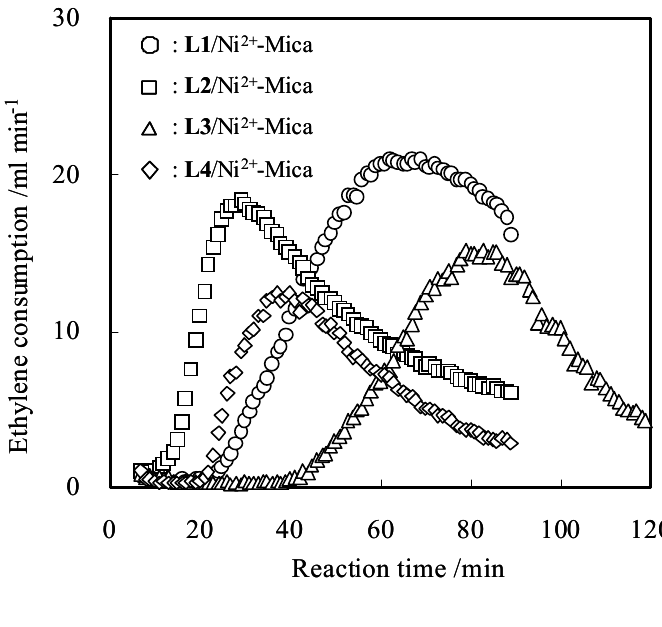
Figure 3. Profiles of ethylene consumption from ethylene oligomerization using L1-4 /Ni 2+ -Mica procatalyst. Reaction conditions are the same as in Table